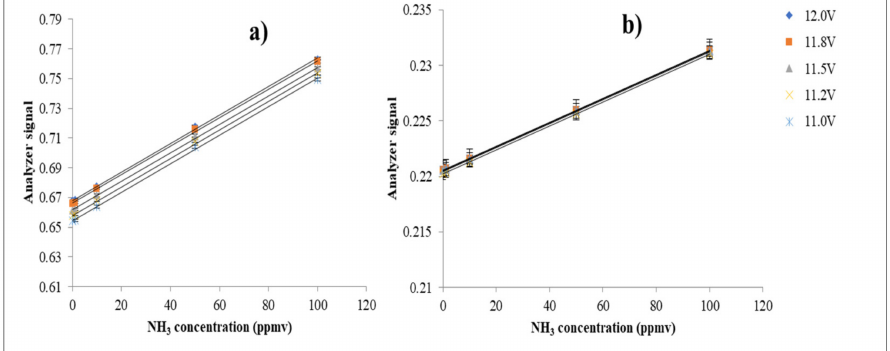
Figure 8. Aging effects of the IR source through its various powers influencing the zero-drift of calibration curves of the NDIR analyzer coupled with the typical reference method ( a ) and the feasible method ( b ).